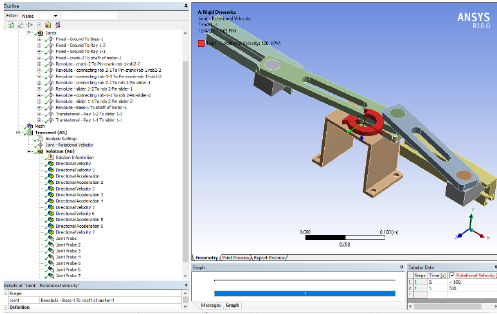
Fig. 4: Set up silulation in ANSYS.